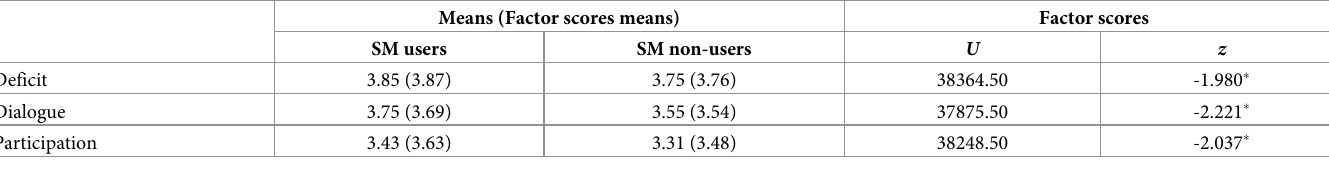
Table 9. Mann-Whitney U